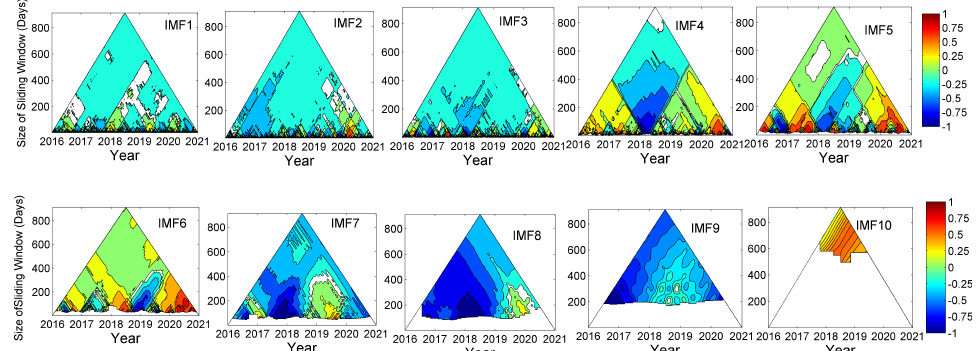
Figure 11. TDIC plots between solar radiation ( SR ) and wind direction ( WD ). The white spaces imply that correlation is not significant at the 5%